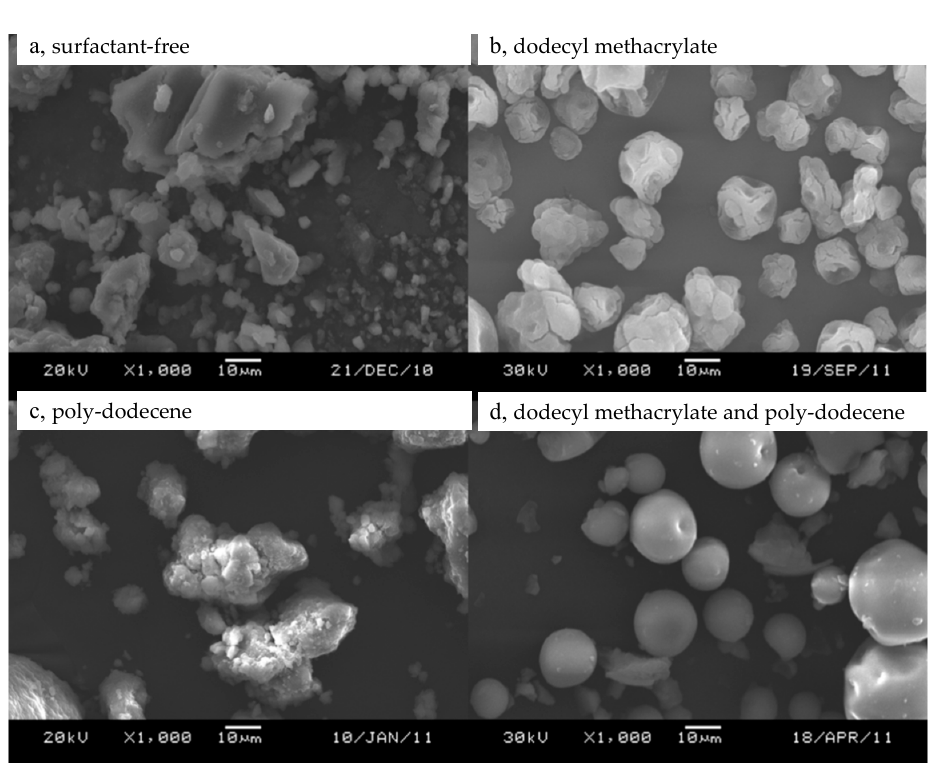
Figure 1. Morphology of the catalyst.